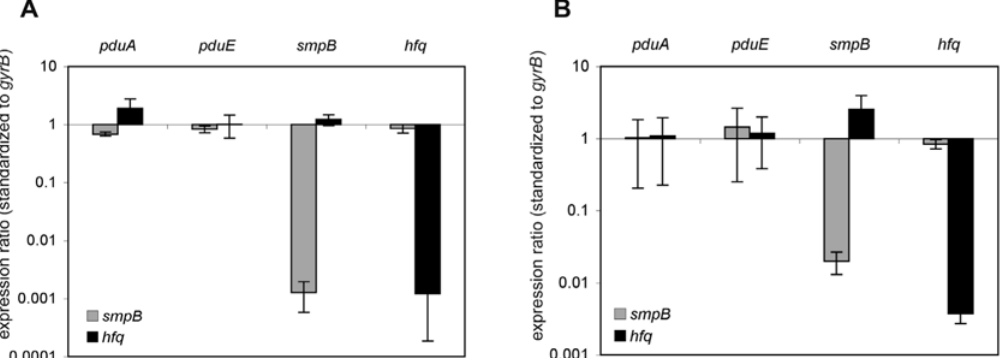
Figure 5. Transcripts of pdu genes remain unchanged in D smpB and D hfq strains. Total RNA was isolated from Salmonella cells grown under acidic minimal media (AMM-2) growth condition (Panel A) or LB Stat growth condition (Panel B) and mRNA level of pdu genes was quantified via RT- PCR using gyrB mRNA level for normalization. As controls the mRNA level of smpB and hfq genes were also quantified in a similar fashion. Expression ratios ( smpB or hfq /14028s) were averaged from three individual experiments and shown on a logarithmic scale.